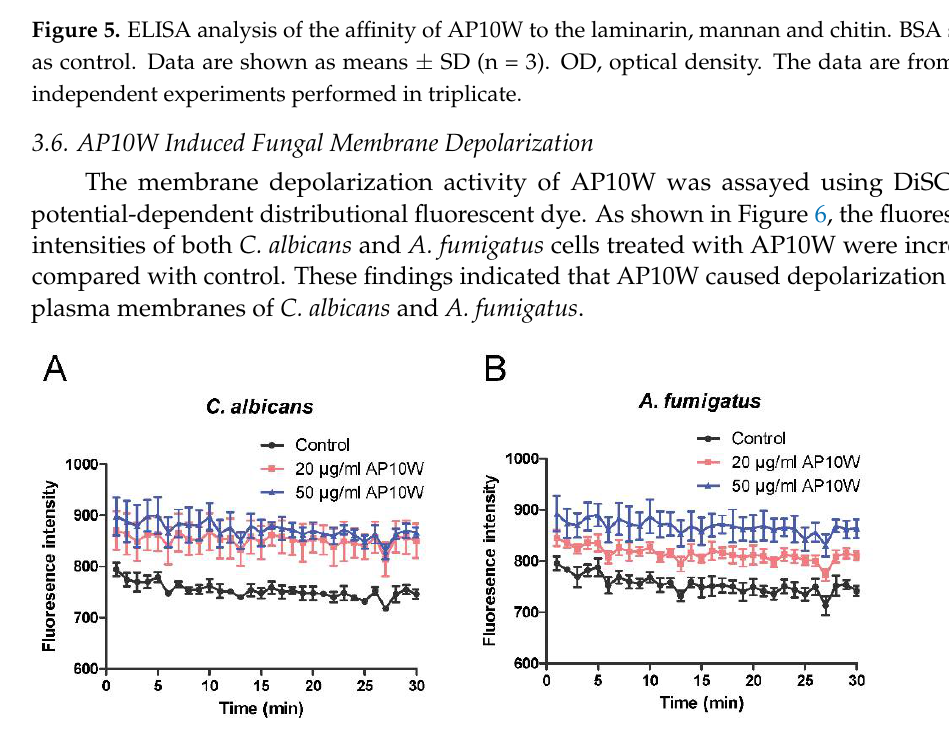
Figure 6. Fungal membrane depolarization. Depolarization of fungal cell membranes were detected using DiSC 3 -5 (excitation, 622 nm; emission, 670 nm). ( A ) The fluorescence intensity of C. albicans treated with different concentrations of AP10W. ( B ) The fluorescence intensity of A. fumigatus treated with different concentrations of AP10W. HEPES buffer containing 20 mM glucose was used as control. Data were expressed as means ± SD (n = 3) from three independent experiments.